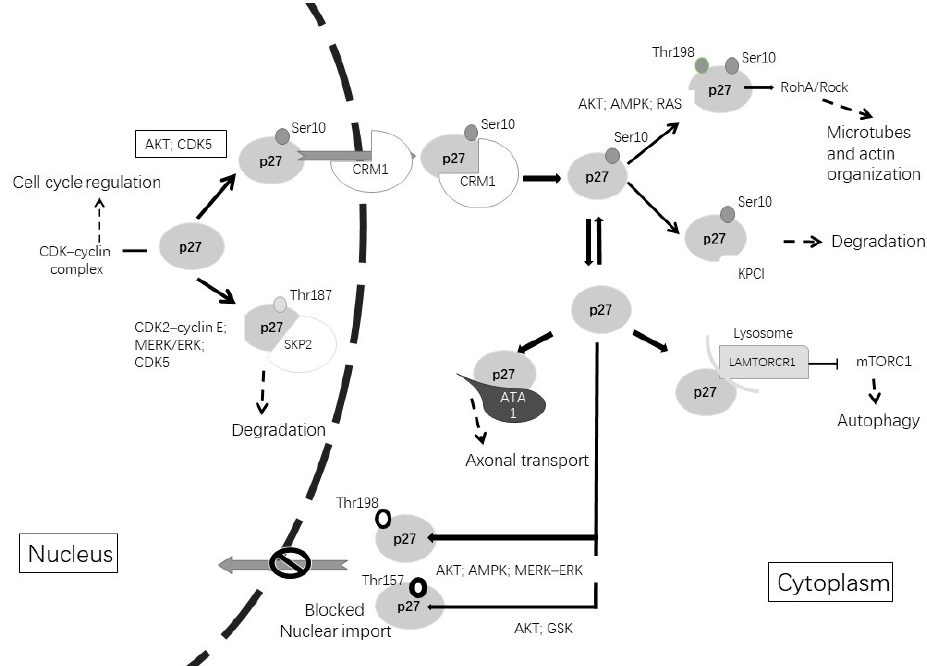
Figure 2. Post-translational modifications of p27 Kip1 lead to changes in its function and alter its subcellular localization. The phosphorylation of p27 Kip1 at Thr187 promotes its degradation in the nucleus. Phosphorylation of p27 kip1 at Ser10 promotes exportation to the cytoplasm by CRM1. Once in the cytoplasm, p27 Kip1 can be degraded or can undergo different phosphorylations. Phosphorylation at Thr157 or Thr198 avoids nuclear reimportation. Cytoplasmic functions include microtubules and actin organization, axonal transport or involvement in autophagy.